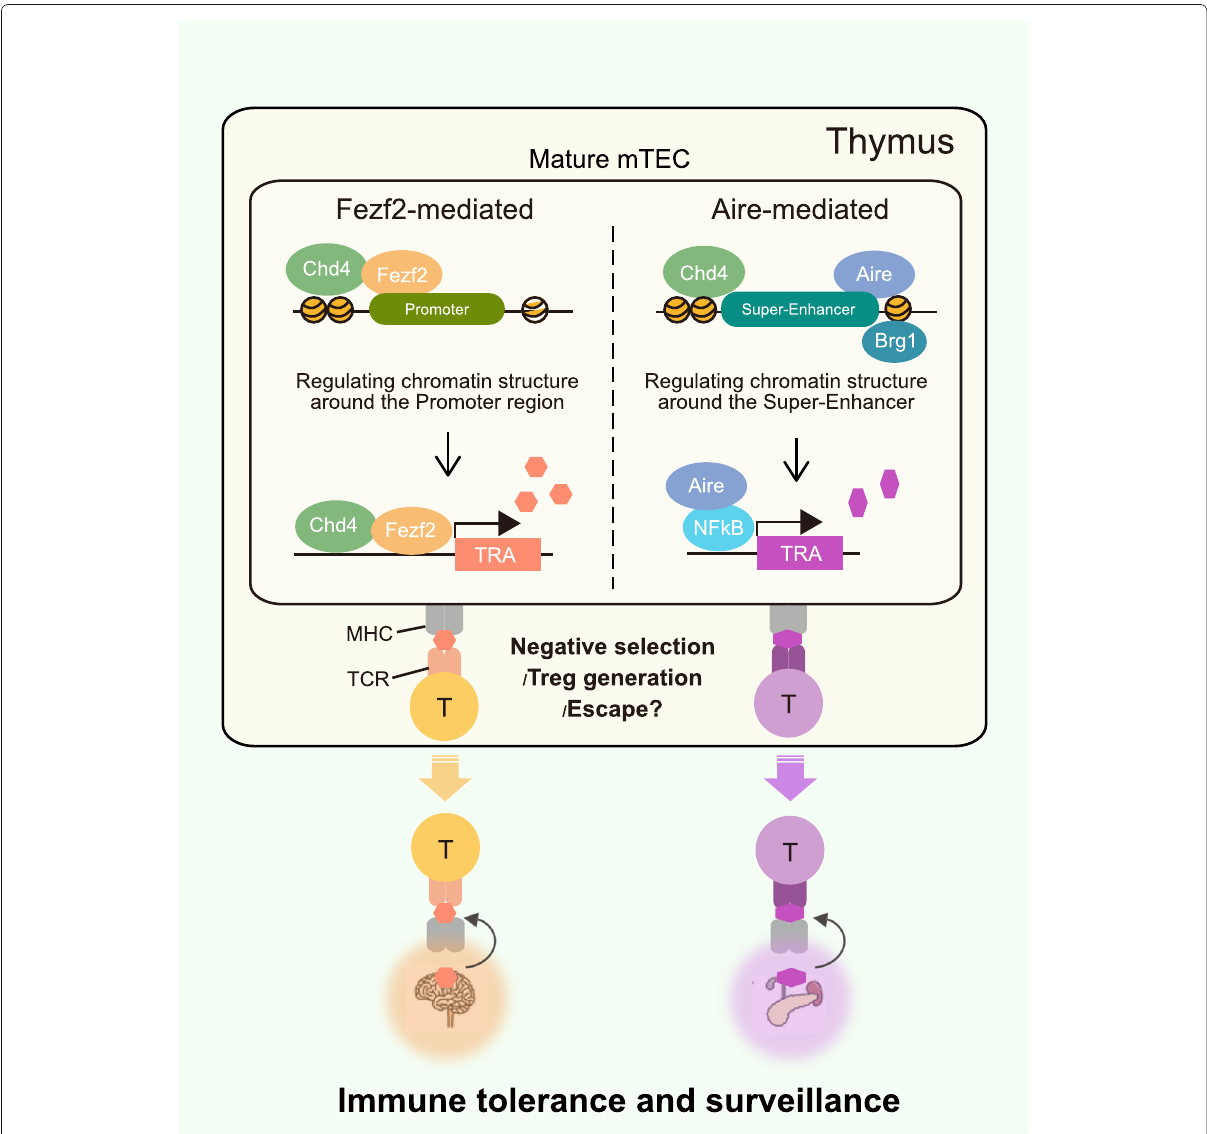
Fig. 2 TRA expression mechanism by Fezf2 or Aire with Chd4 in mTECs in the thymus for immune homeostasis and surveillance: Super-enhancer mediated TRA expression by Aire (right), typical-enhancer mediated TRA expression by Fezf2 which forms NURD complex with Chd4 on the promoter regions (left). TRA-recognizing T cells differentiate into Treg cells or escape as autoreactive T cells from the thymus. Such T cells migrate to the secondary lymphoid organs and are distributed in specific peripheral tissues for immune homeostasis or surveillance